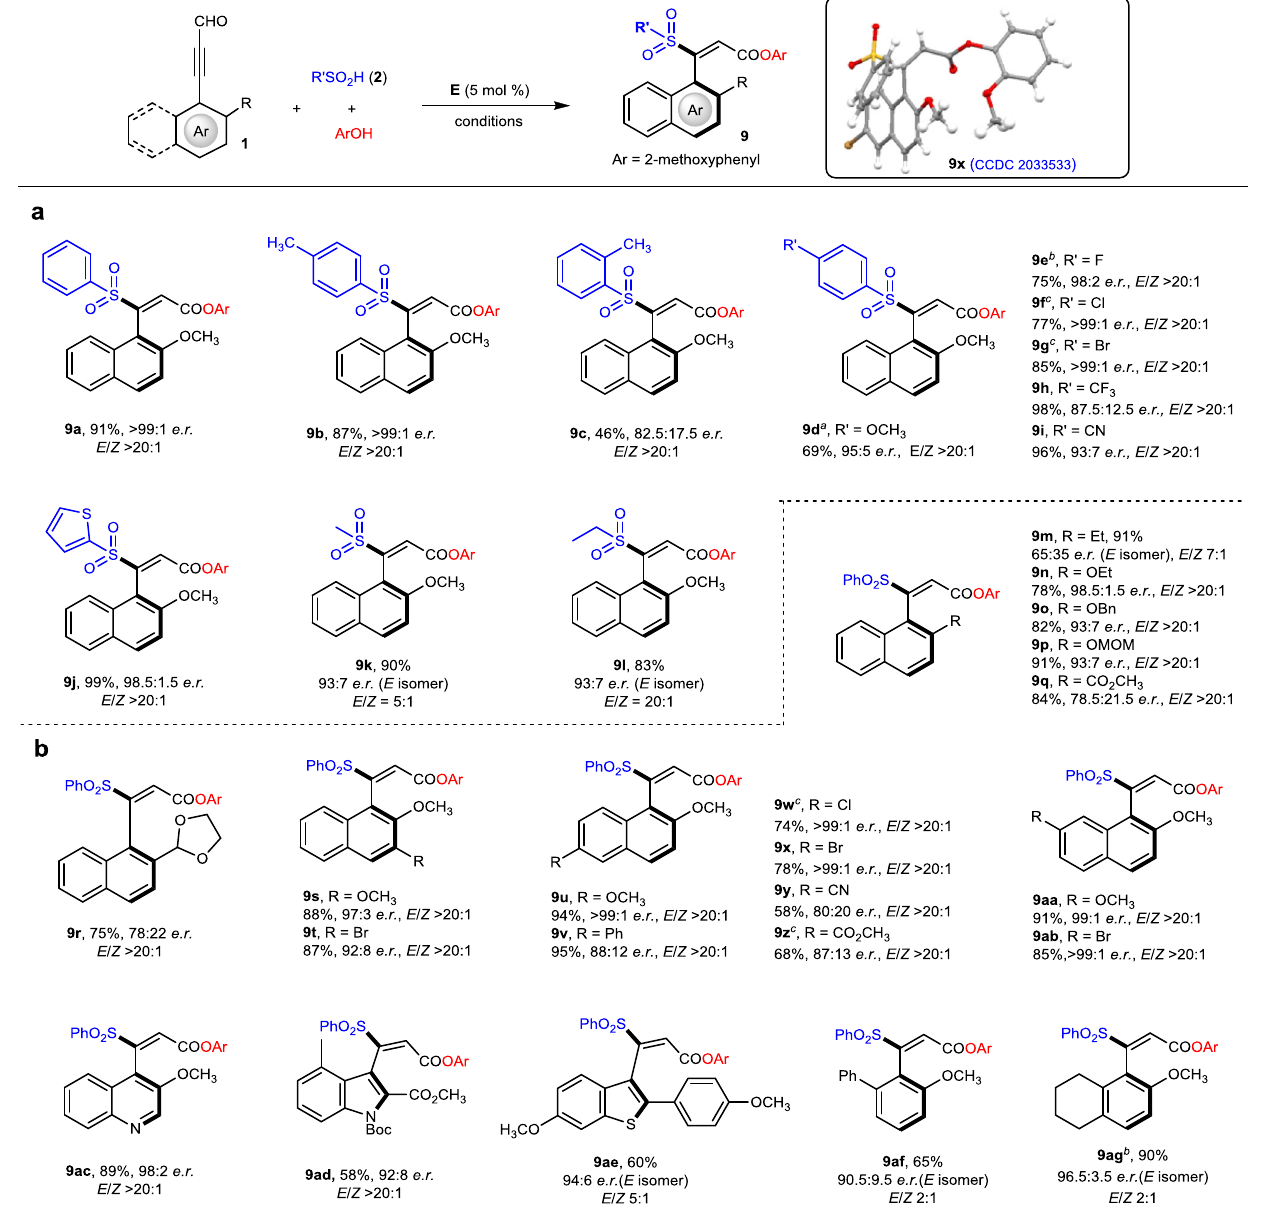
Fig. 2 Scope of the reaction. a Variations of sul fi nic acids. b Variations of ynals. Standard reaction conditions: 1a (0.1 mmol), 2a (0.2 mmol), E (5 mol%),